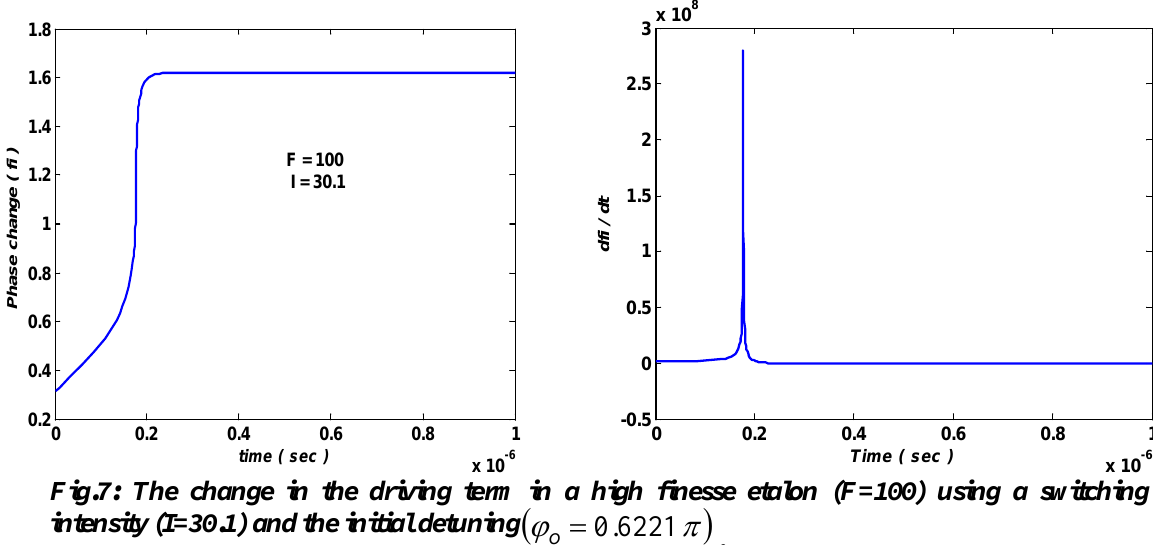
Fig.7: The change in the driving term in a high finesse etalon (F=100) using a switching intensity (I=30.1) and the initial detuning ( ) πϕ 6221.0 = o